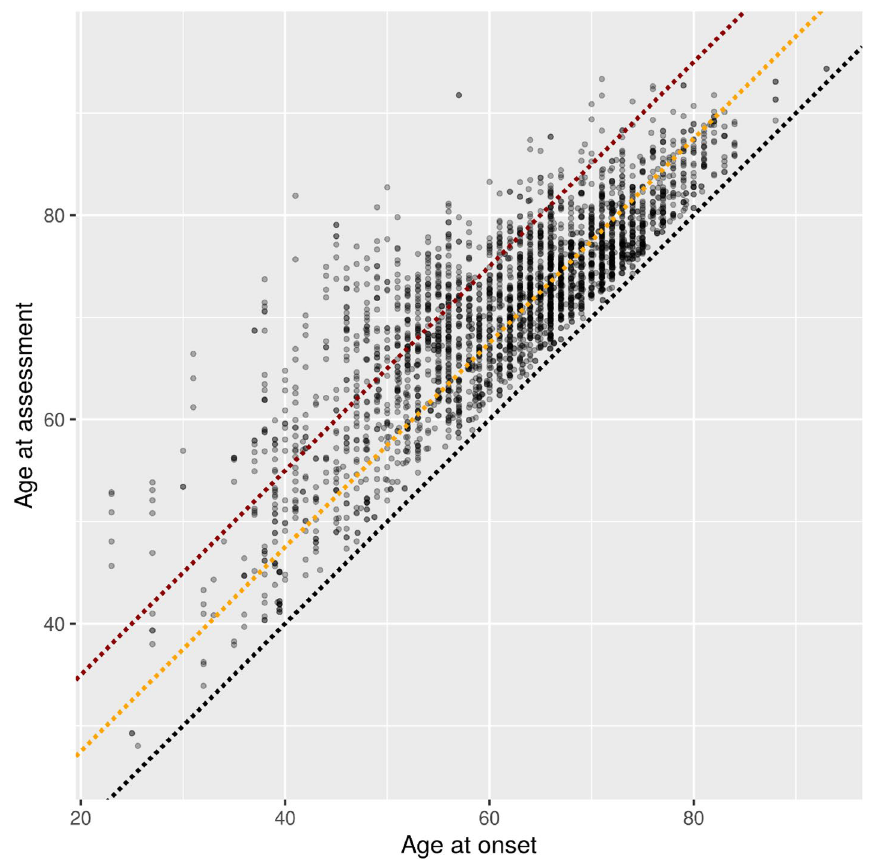
Figure 2. Patient ages at study visits against patient age at onset. The black line represents age at onset, the orange line represents 7.5 years after onset, and the dark red line represents 15 years after